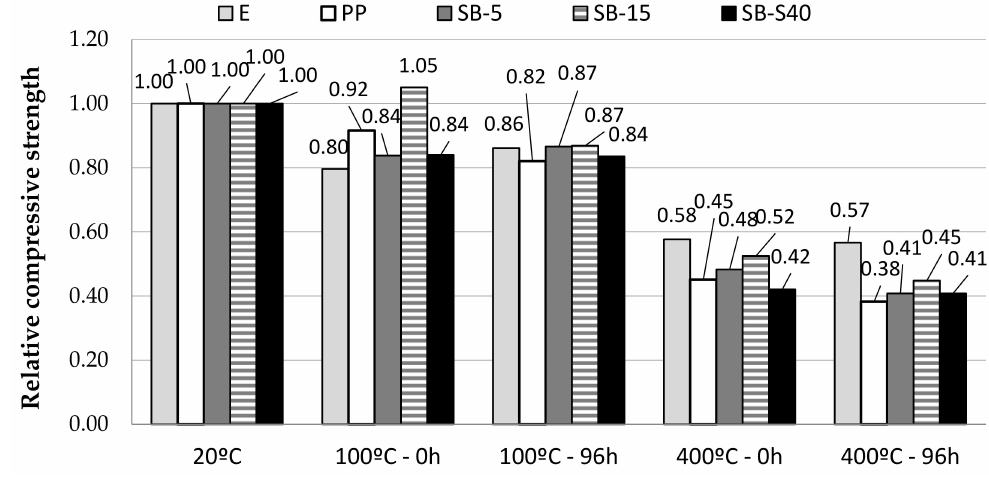
Figure 12. Residual compressive strength of specimens compared with the compressive strength of the same mixture at room